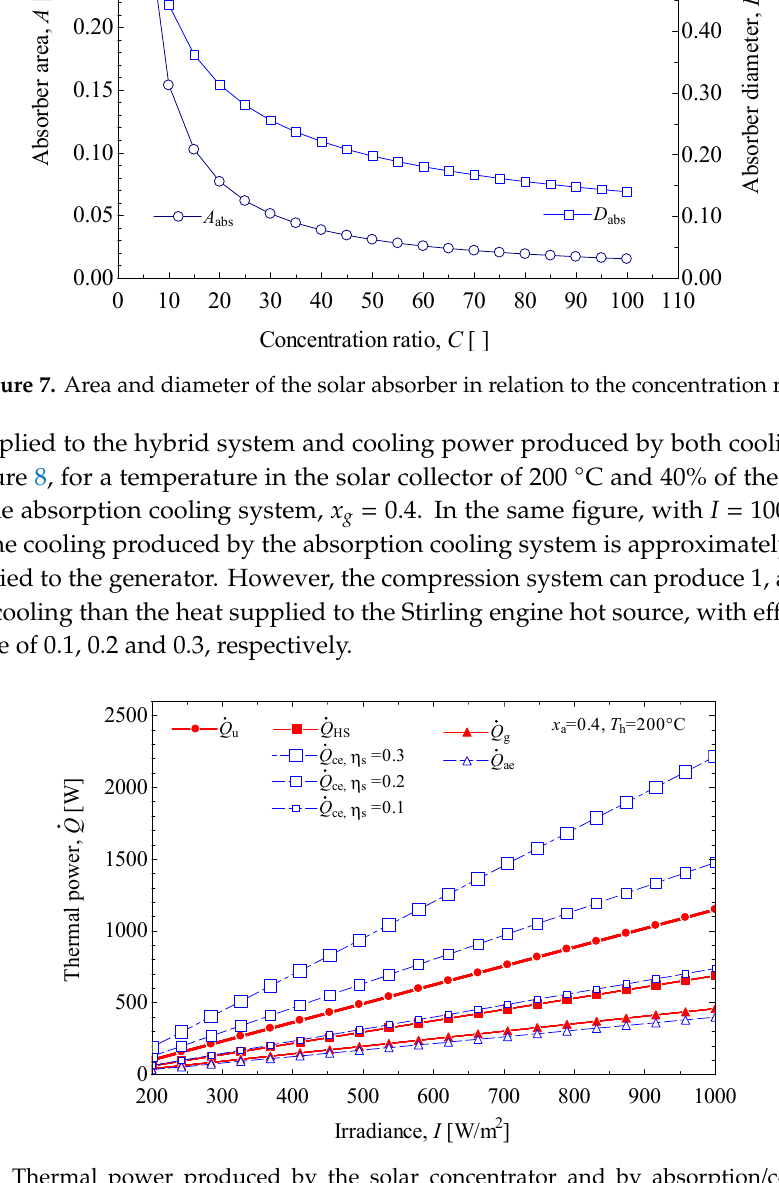
Figure 9. Efficiency of the solar concentrator with respect to ( T i − T o )/ I at 3 hot spot temperatures. To show the relationship between the performances of the different systems that compose the solar hybrid chiller, Figure 10 shows the efficiency of the solar concentrator, together with the COP of the two cooling systems, as a function of the solar radiation. In the figure, the solar concentrator efficiency is in the range from 0.33 to 0.75. COP of the absorption system is 0.85, while COP of the compression system is 11, when T h = 200 °C, T e = 10 °C and T c = 28 °C.